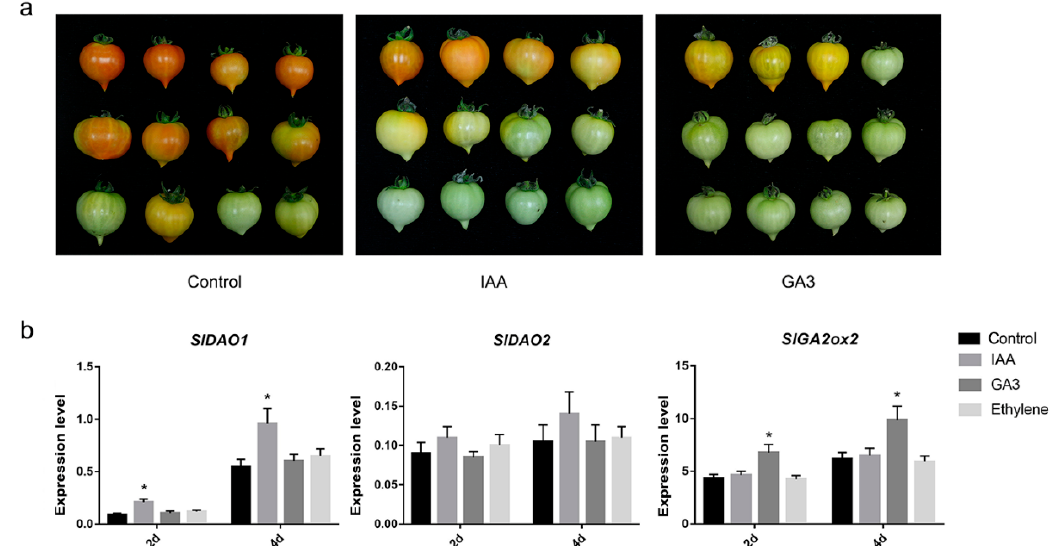
Figure 6. Expression analysis of SlDAO1 , SlDAO2 , and SlGA2ox2 after auxin, GA 3 , and ethylene treatments. ( a ) Photos of mature-green fruits after indole-3-acetic acid (IAA) and gibberellin 3 (GA 3 ) treatment, respectively. ( b ) Expression analysis of SlDAO1, SlDAO2 , and SlGA2ox2 after auxin, GA 3 , and ethylene treatments. * The asterisk at the top of each column indicates a significant difference at p < 0.05 ( n = 3) by students t-test.